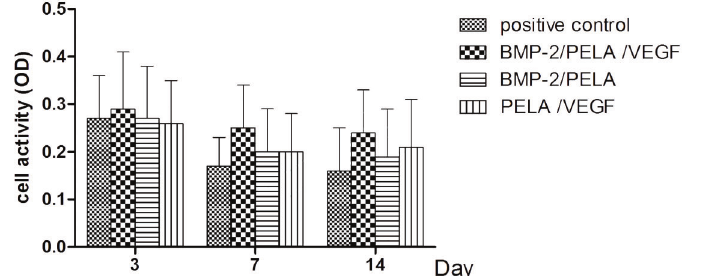
Figure 2. Results of the MTT assay after incubation of cells with PELA scaffolds. Cells cultured in the absence of scaffolds served as the positive control. Data are reported as means ± SD. BMP-2: bone morphogenetic protein-2; PELA: polylactide-poly (ethylene glycol)-polylac- tide; VEGF: vascular endothelial growth factor.